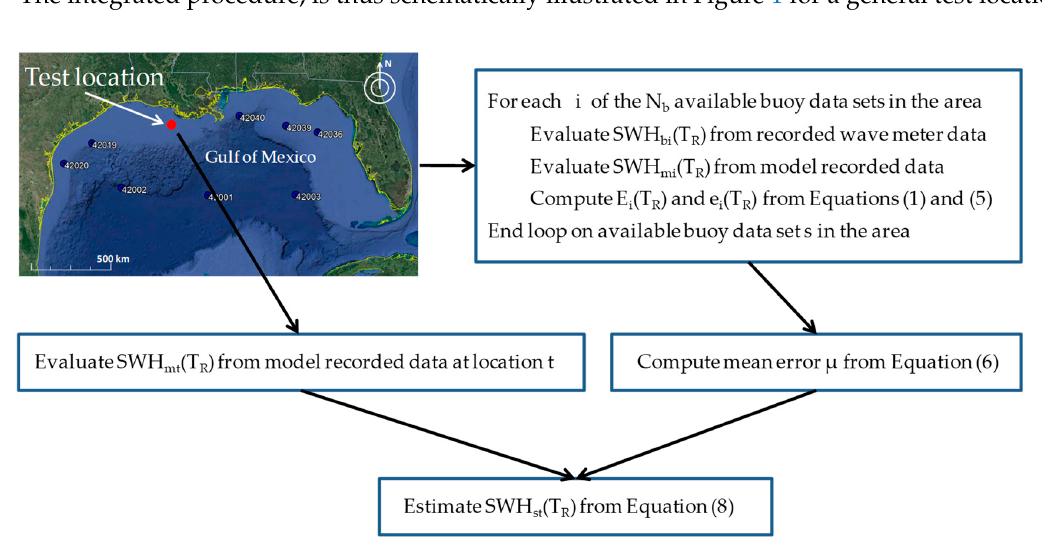
Figure 1. Integrated workflow to evaluate SWH st at location t for T R return time.